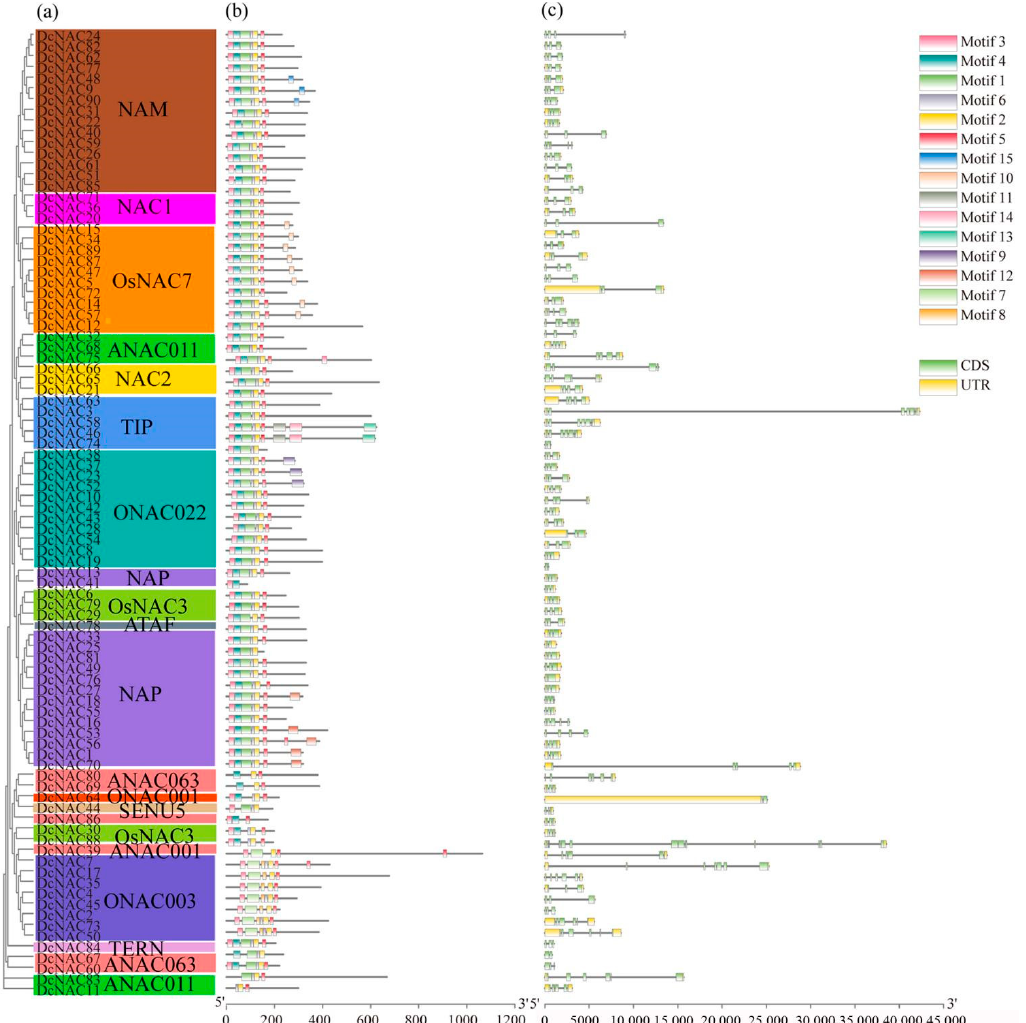
Figure 2. Motifs, structures, and phylogenetic relationships of DcNAC family members. ( a ) A phylogenetic tree of 90 DcNAC proteins was constructed using the maximum likelihood method. The different subgroups are indicated with different background colors and letters. ( b ) Conserved motifs of DcNAC proteins. Different motifs are represented by different colored boxes. ( c ) Exon/intron structures of DcNAC genes with UTR(s), exon(s), and intron(s) are indicated with yellow and green boxes, and black lines, respectively. The phylogenetic tree, conserved motifs, and gene structures were predicted with TBtools.